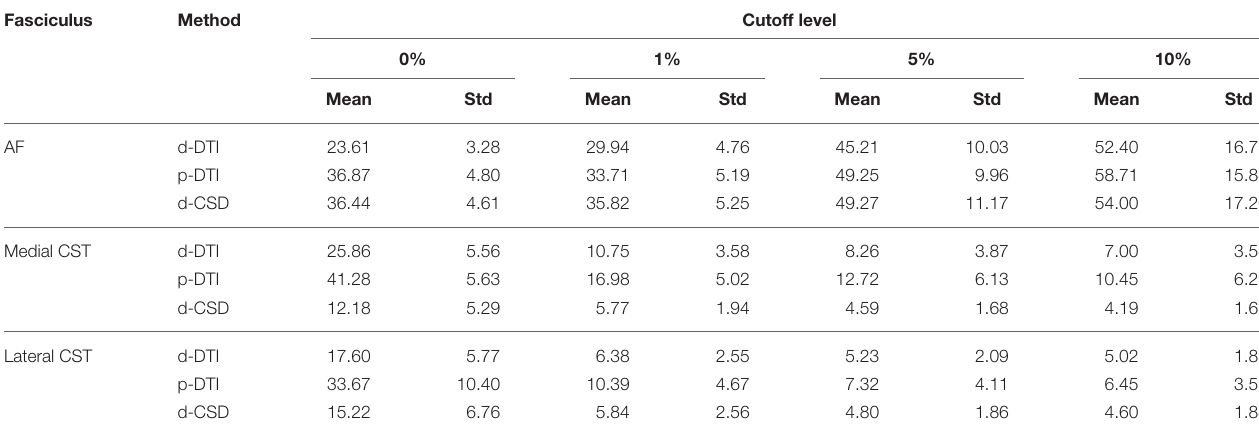
TABLE 1 | OF analysis results. Fasciculus